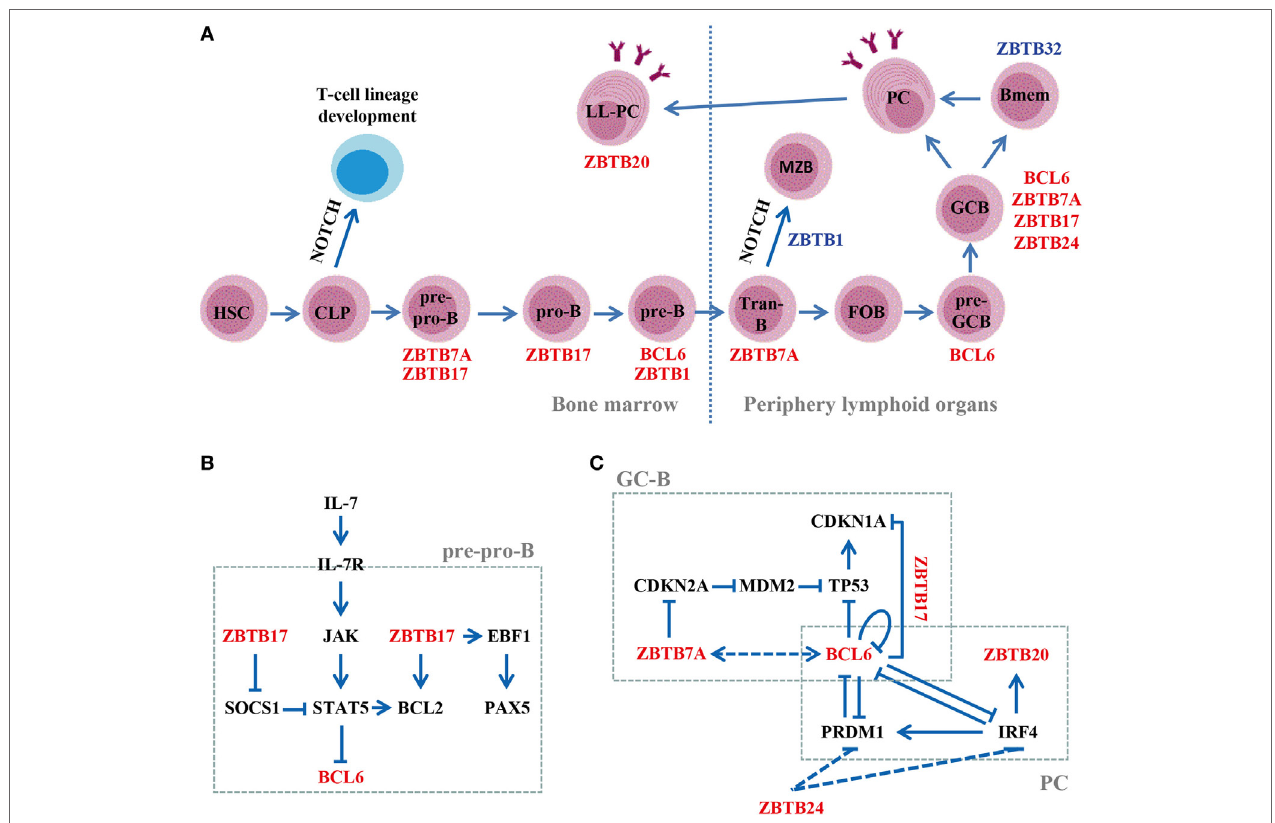
FigURe 2 | Roles of ZBTB proteins in B-cell development, differentiation, and function. (A) A schematic view of the stages most affected by ZBTB proteins along the B-cell development program. ZBTB7A, ZBTB17, ZBTB1, and BCL6 regulate early B-cell development in the bone marrow, while ZBTB7A, BCL6, ZBTB17, ZBTB1, ZBTB20, ZBTB24, and ZBTB32 function in mature B-cell compartments. Positive/negative regulators are indicated in red/blue, respectively. (B) Regulation of the IL-7R signaling pathway by ZBTB17 in pre-pro-B cells. ZBTB17 plays a dual role by inducing BCL2 while repressing SOCS-1. (C) Transcriptional regulation of genes important for the GC-B or plasma cell (PC) development. Dotted lines represent data obtained in cell lines, and the in vivo functional relevance remains to be confirmed . Tran-B, transitional B cells; LL-PC, long-lived